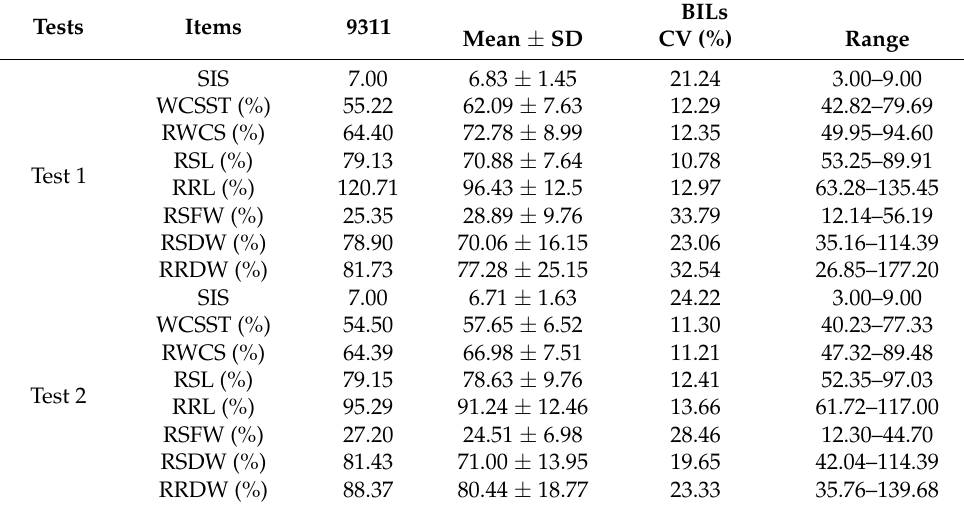
Table 1. The main performance of O. longistaminata BILs under salt treatment at seedling